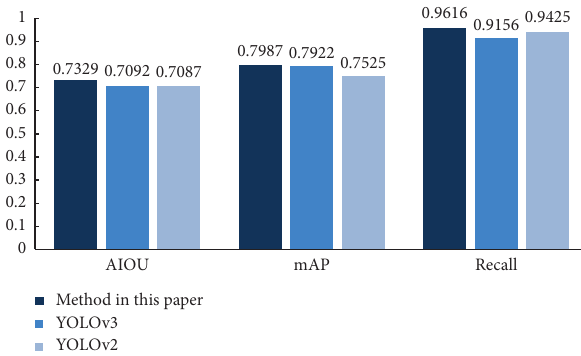
Figure 16: The comparison of the network performance indexes among YOLOv2/v3 and the improved RDCNN.